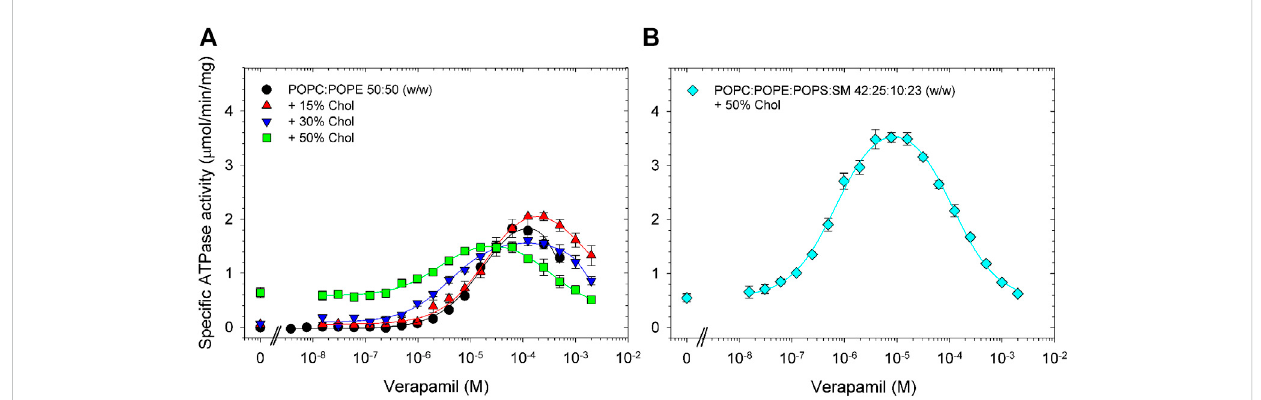
FIGURE 3 Effects of cholesterol on the verapamil-stimulation of ATPase. Puri fi ed Pgp was activated with 10 mM DTT and (A) POPC:POPE (50:50, w/w) lipid supplemented with 15% (w/w), 30% or 50% cholesterol. (B) A POPC:POPE:POPS:SM mixture (42:25:10:23, w/w) plus 50% cholesterol was used. ATPase activity was assayed as described in Experimental Procedures. Data points represent the mean ± SEM ( n = 3).